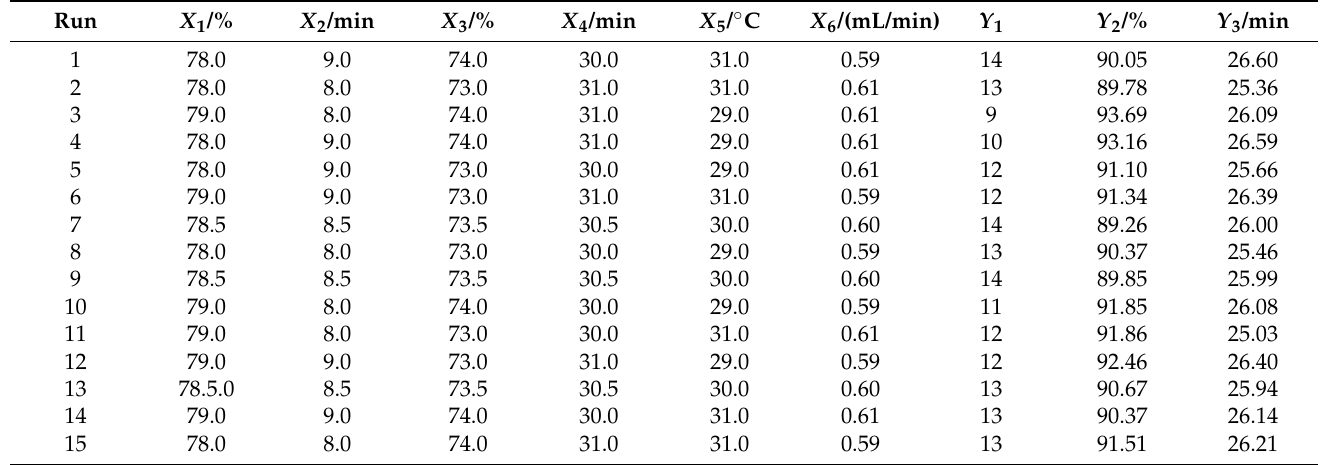
Table 4. Experimental conditions and results of Plackett–Burman designed